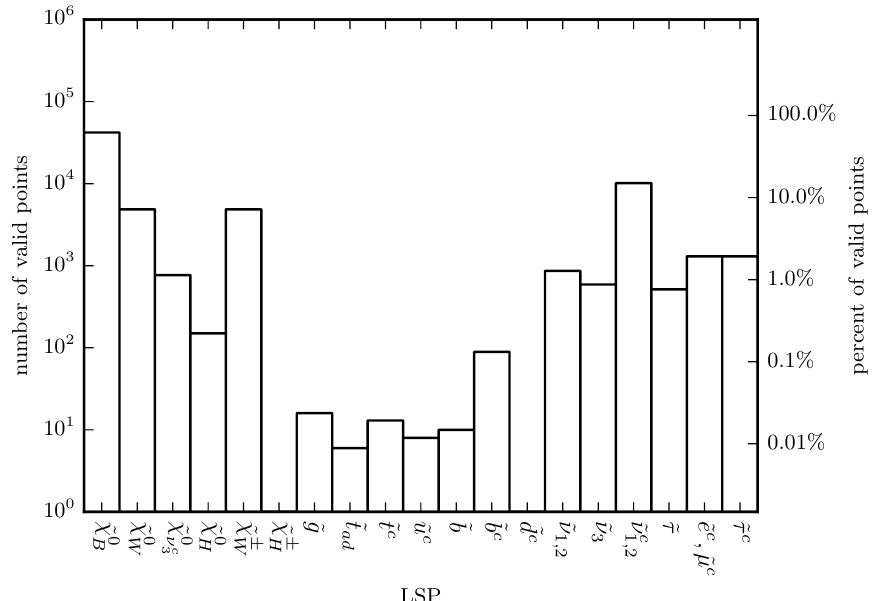
Figure 2. A histogram of the LSPs associated with a random scan of 100 million initial data points, showing the percentage of valid black points with a given LSP. Sparticles which did not appear as LSPs are omitted. The y-axis has a log scale. The notation and discussion of the sparticle symbols on the x-axis were presented in